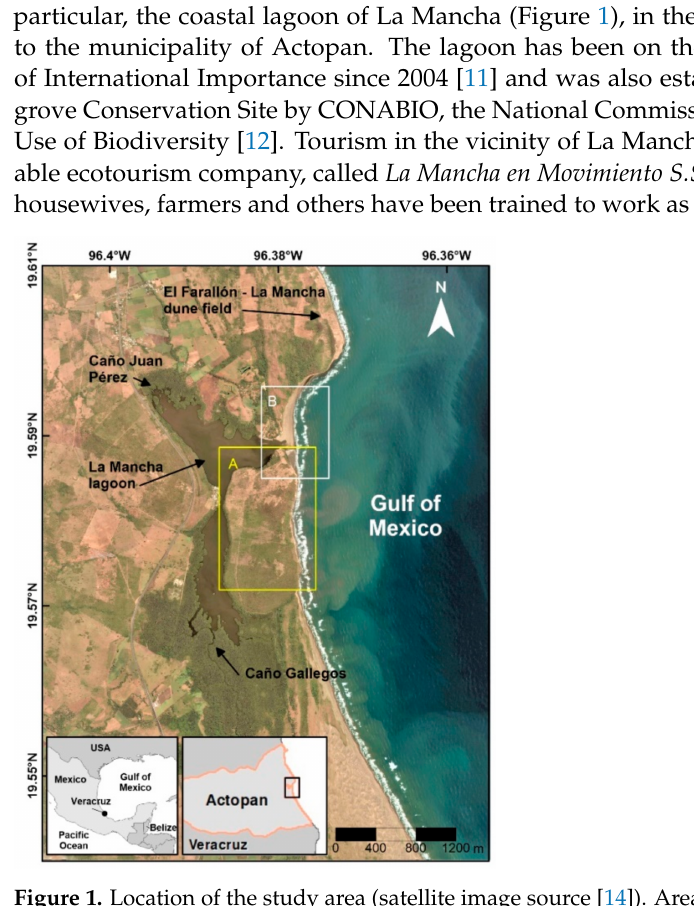
Figure 1. Location of the study area (satellite image source [14]). Area A is the site of a recent urban development project. Area B is the beach and lagoon inlet